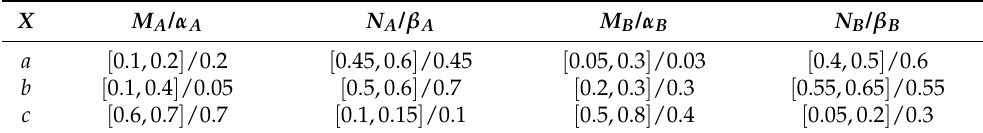
Table 2. CISs A and B